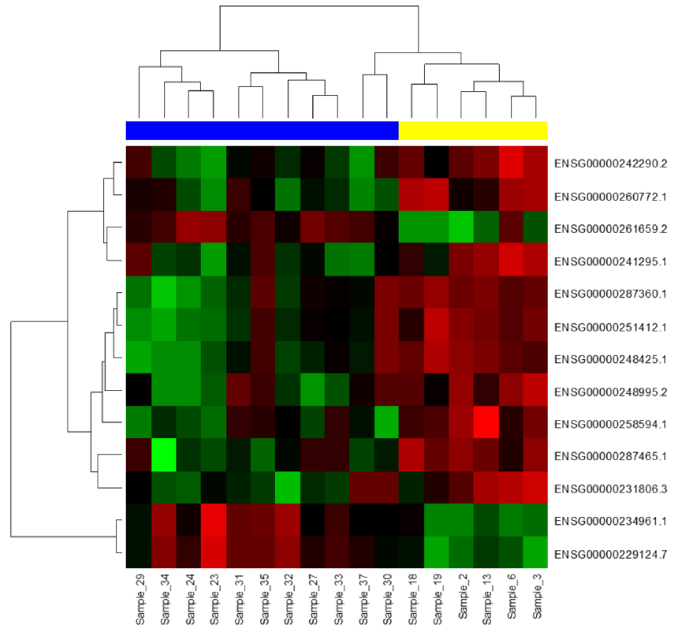
Figure 1. Hierarchical clustering and heatmap visualizing 13 lncRNAs differentially expressed between six multiple myeloma (MM) samples (yellow) and eleven plasma cell leukemia (PCL) samples (blue) ( p ≤ 0.00025) in the exploration phase of the study. Red represents high expression levels, and green represents low expression levels.